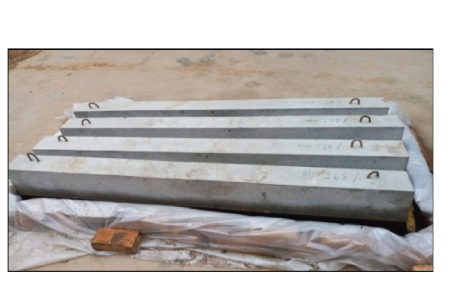
Figure 4: Deicing salt